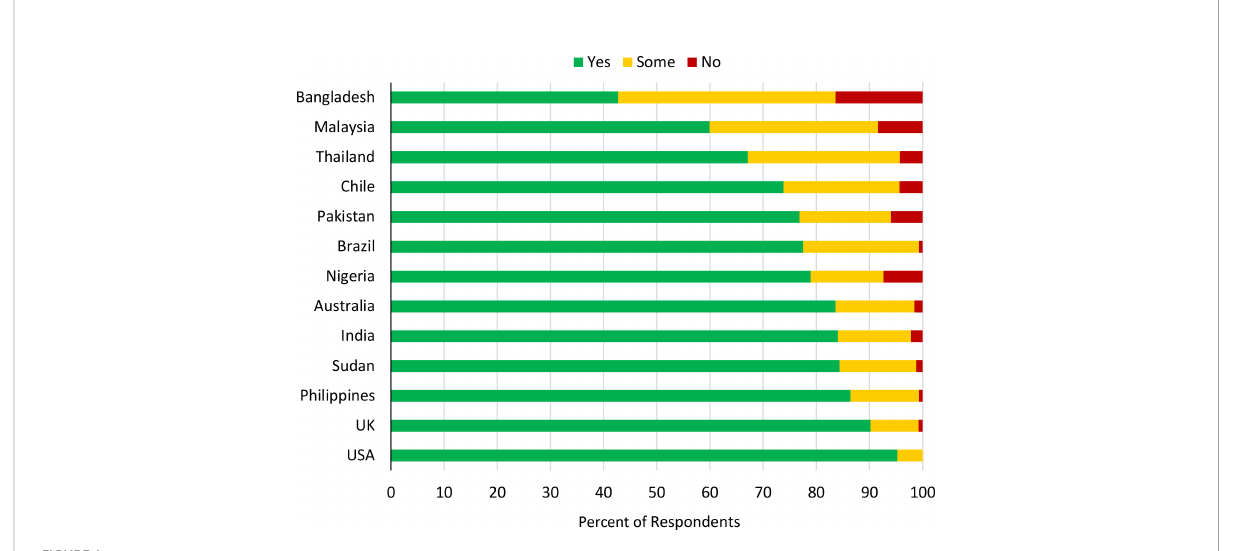
FIGURE 1 Responses to ‘ I understand what animal welfare means ’ in percentages, by country, ranked in ascending order of full